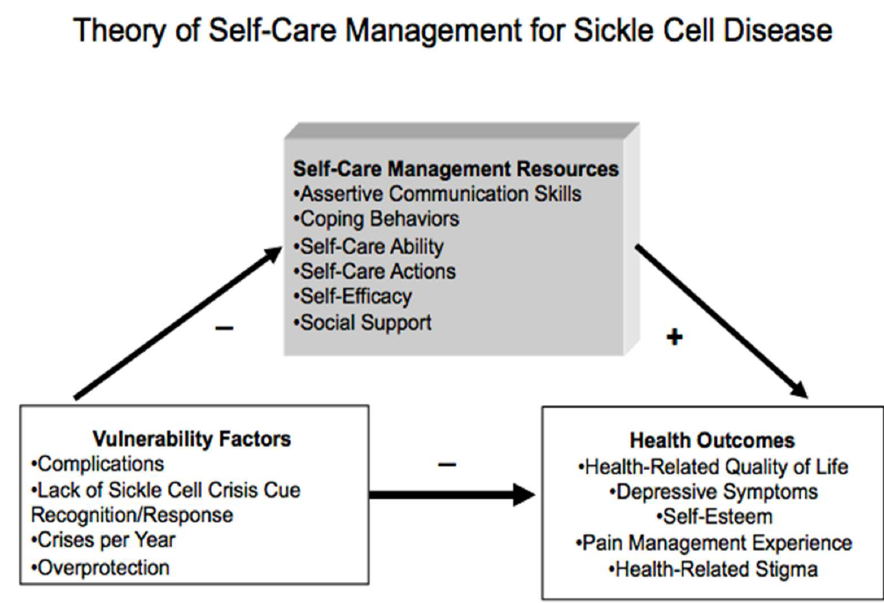
Figure 1. Theory of Self-Care Management for Sickle Cell Disease (SCMSCD).